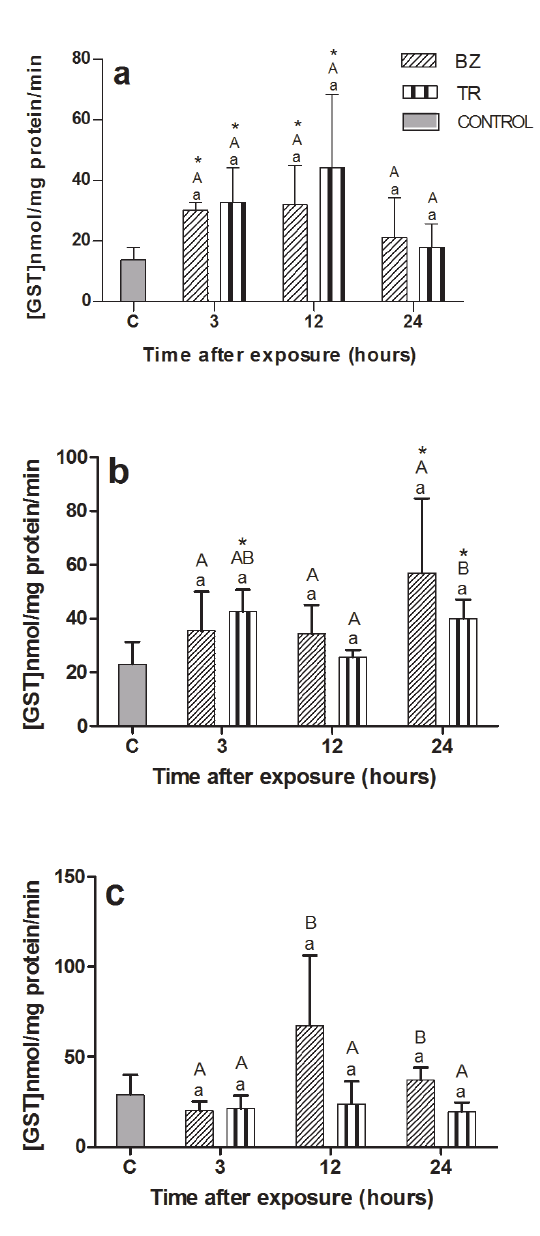
Figure 1 - Total antioxidant capacity (ACAP) of gills ( a ), liver ( b ) and brain ( c ) of juvenile tambaqui, Colossoma macropomum anesthetized with benzocaine or tricaine. Values are expressed as means ± SD. Different lowercase letters indicate significant differences between treatments (anesthetics) within sampling time; different capital letters indicate significant differences within treatment over time; asterisk indicates significantly different from control (C) (n = 10, p<0.05).